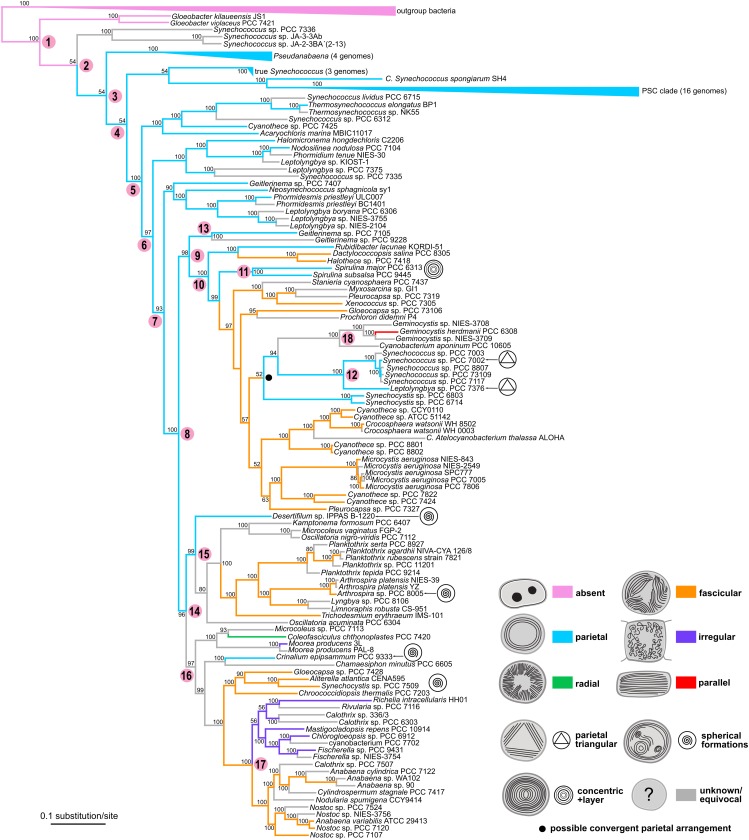
Phylogenetic tree of cyanobacteria inferred from 260 housekeeping proteins with traced evolution of thylakoid arrangement. The tree was calculated using the maximum-likelihood method from an alignment of 148 sequences rows spanning 156,762 amino acid positions. BP values (500 repetitions) are displayed near the nodes. Numbers in parentheses represent the number of sequences in collapsed branches. Color-coded thylakoid arrangements in non-terminal nodes were inferred using the parsimony ancestral reconstruction method. Special features in thylakoid architecture are indicated with pictograms. Reconstructed convergent occurrence of the parietal arrangement is marked with a filled black circle. Selected nodes, which are referred to in the main text, are numbered to facilitate tree description. Collapsed nodes containing taxa with a single category of thylakoid arrangement together with taxa with unknown ultrastructure are color-coded according to the known category. PSC clade = Prochlorococcus, marine Synechococcus, and Cyanobium.